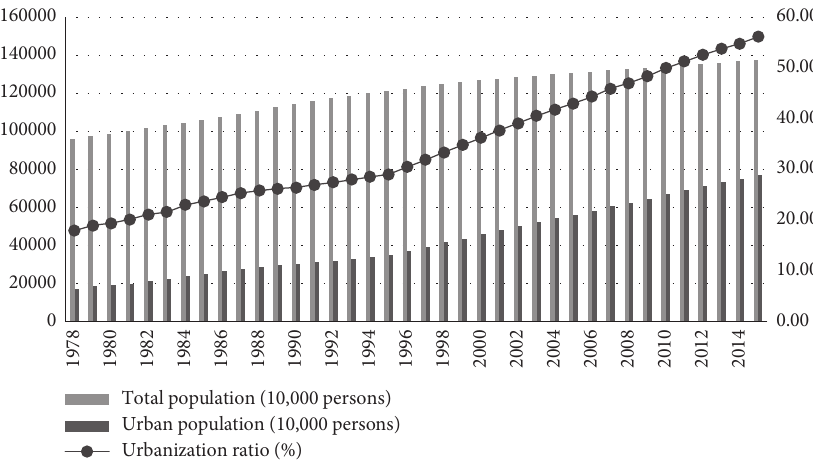
Figure 1: Changes in urban population and urbanization ratio in China,